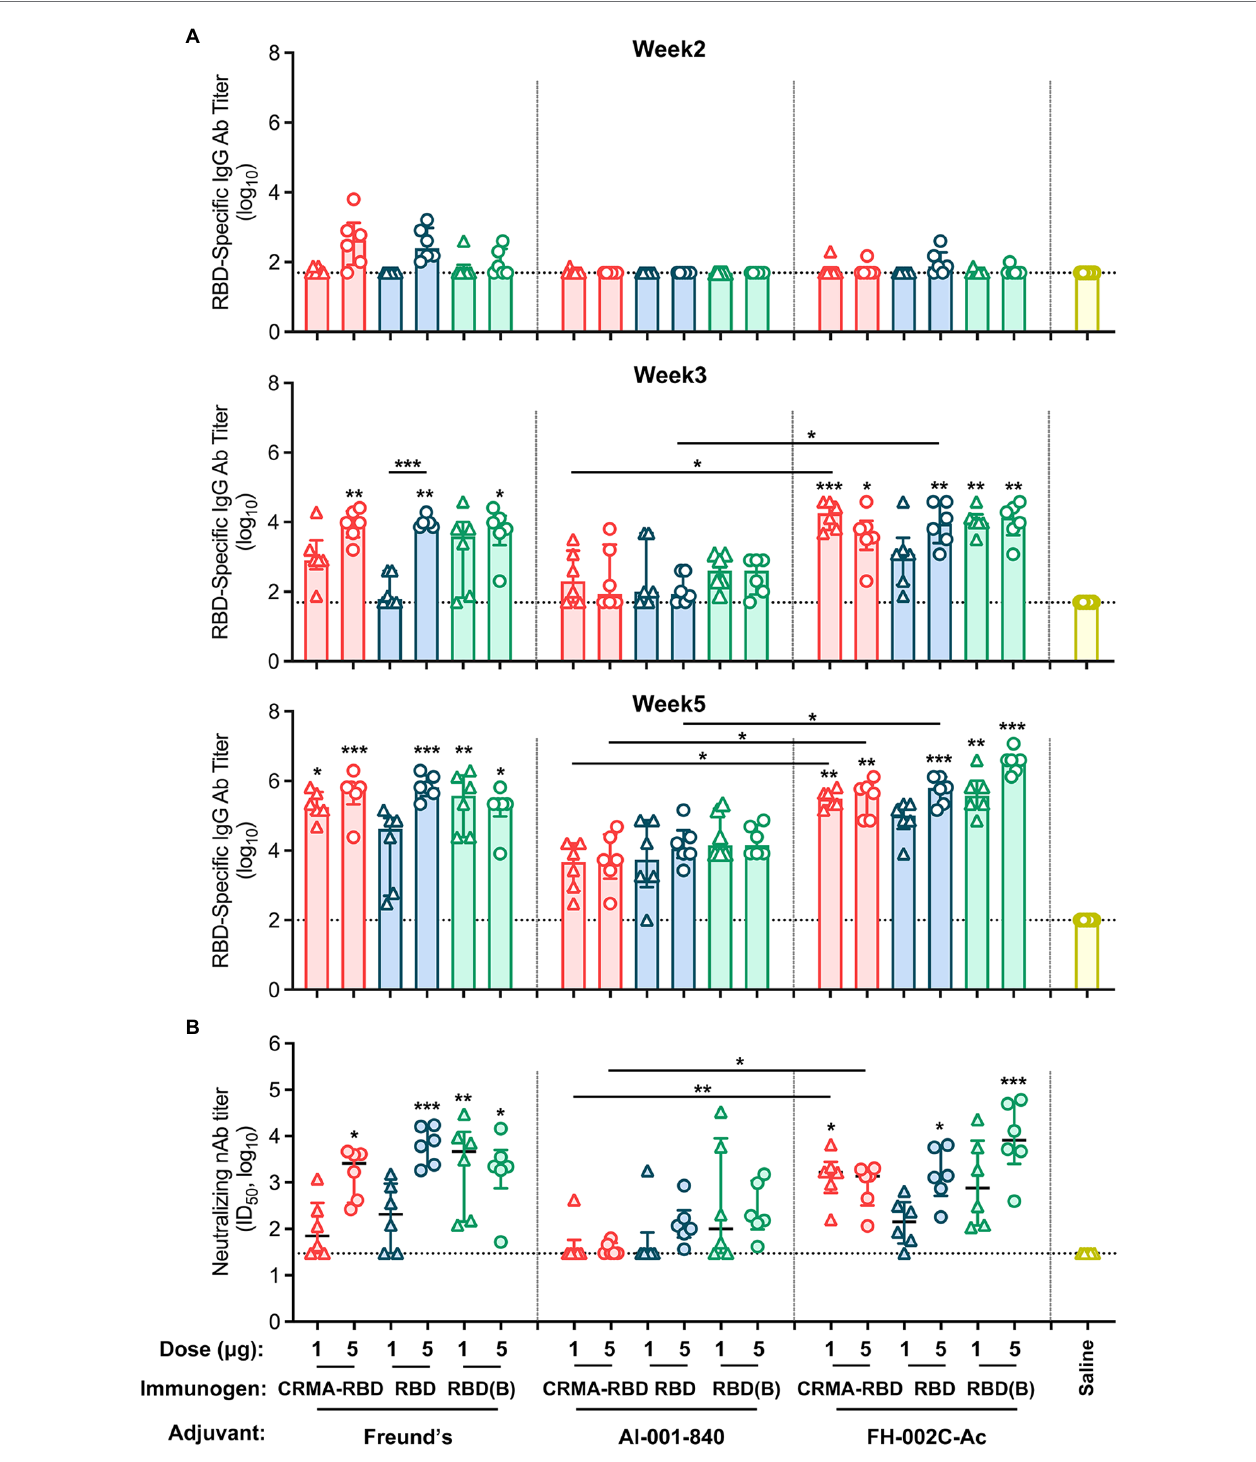
FIGURE 3 | Immunogenicity of CRMA-RBD, RBD, and RBD (Bac) in mice. (A) IgG titers induced by CRMA-RBD, RBD, or RBD (Bac) in BALB/c mice ( n = 6). Mice were immunized with 1 or 5 μ g of CRMA-RBD, RBD, or RBD (Bac), delivered with Freund’s adjuvant, Alum adjuvant (Al-001-840) or the FH-002C-Ac adjuvant at weeks 0, 2, and 4. (B) Neutralizing antibody titers of the immune sera at week 5, corresponding to the samples showing IgG titers in ( A , bottom panel). Data were plotted as median ± IQR. The statistical significance was determined by a Kruskal–Wallis test with Dunn’s multiple comparisons test. p values: * p < 0.05, ** p < 0.01, and *** p < 0.001. p values are indicated in the plots: p values above column corresponding the difference between the group and the saline group; p values above line corresponding the difference between two independent groups. RBD (B): RBD